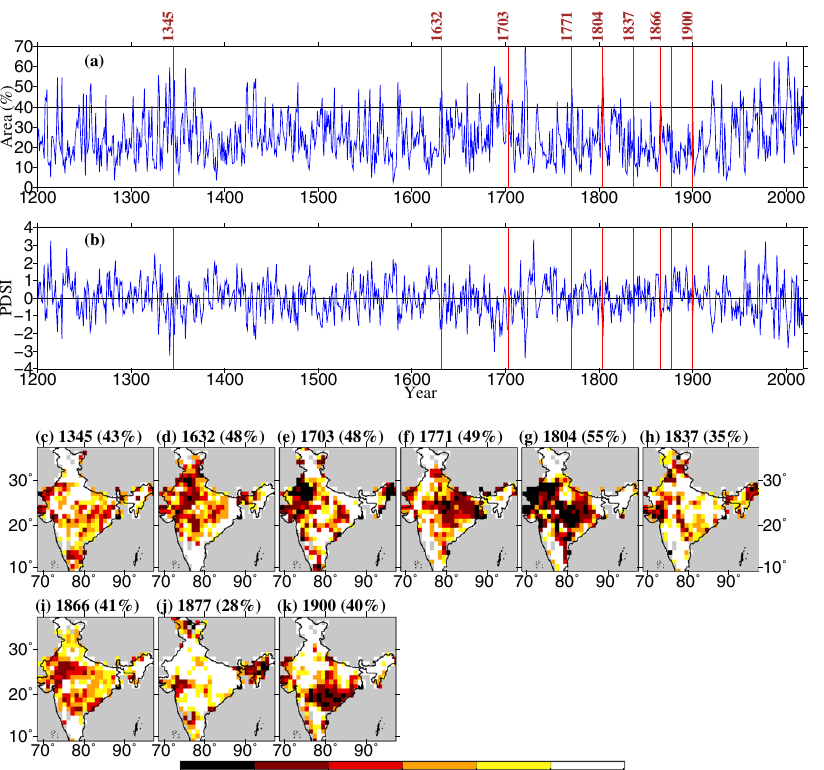
Fig. 2 Major famines caused by drought in India during 1200 – 2018. a Area (%) under drought estimated using Palmer Drought Severity Index (PDSI) less than − 1, b summer monsoon PDSI during 1200 – 2018, c – h years that experienced peak drought during the nine major famines that occurred in the 1200 – 2018 period. Values in parenthesis in ( c – h ) show the area (%) under drought for the peak intensity. Vertical pink lines in ( a , b ) indicate the occurrence of the nine major famines caused by the summer monsoon failures during 1200 –